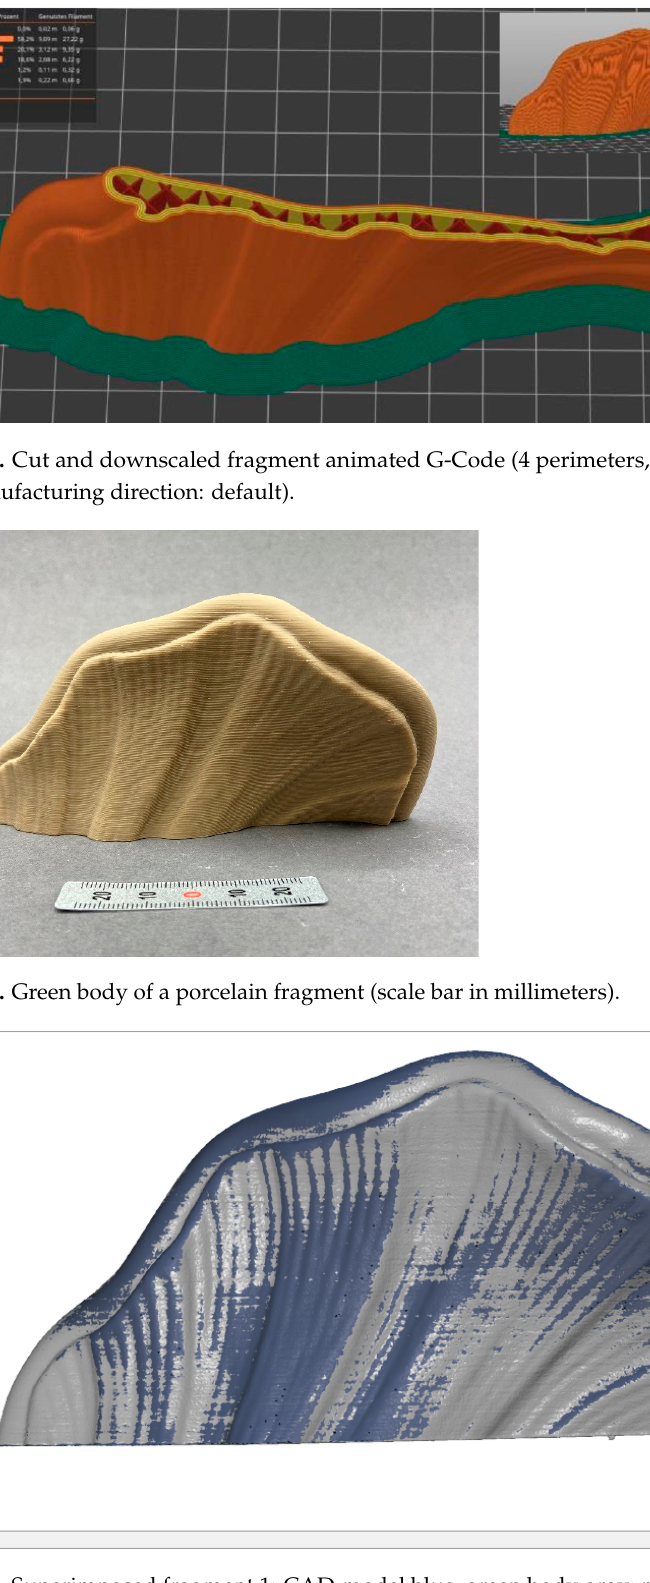
Figure 12. Superimposed fragment 1: CAD-model blue, green body gray; manufacturing direction: clockwise.